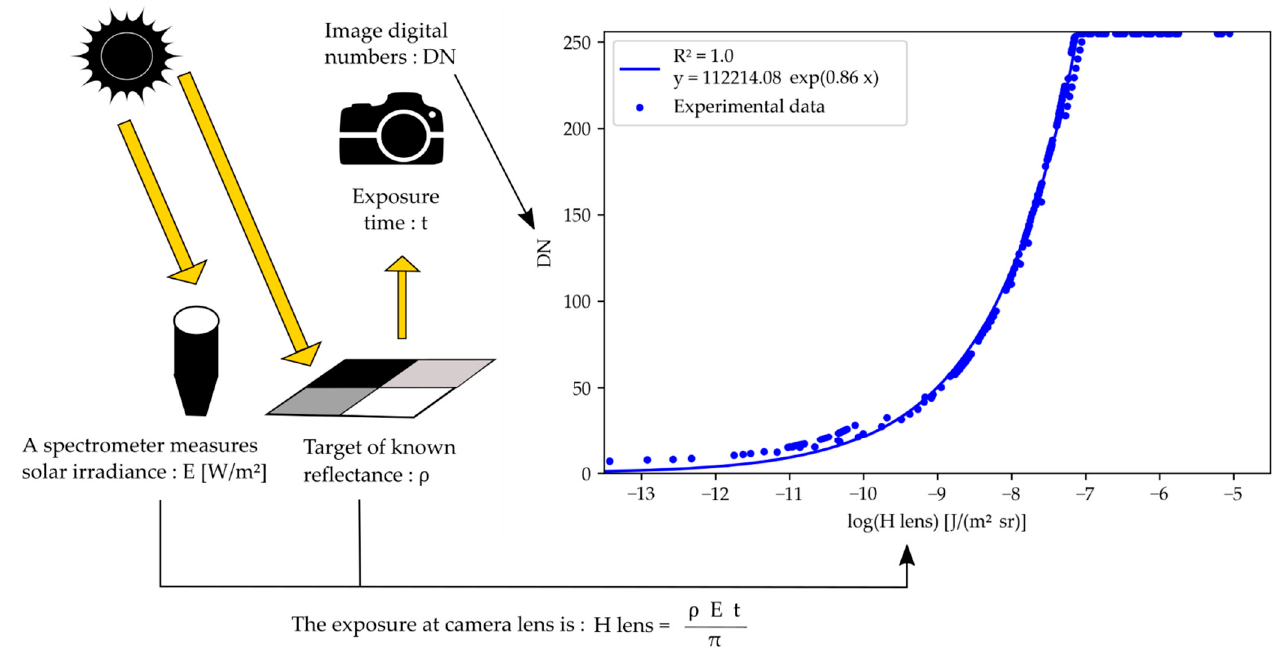
Figure 1. Method to build a camera response curve linking the image digital numbers and the exposure at camera lens. The curve used as example is the response curve of the 490 nm camera.